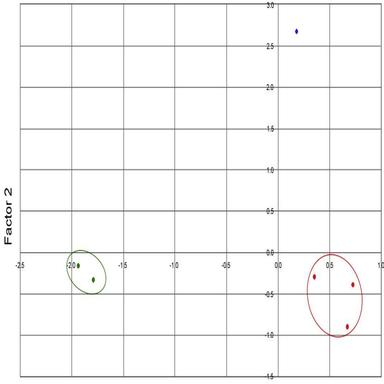
Score graphic of the analyzed samples.